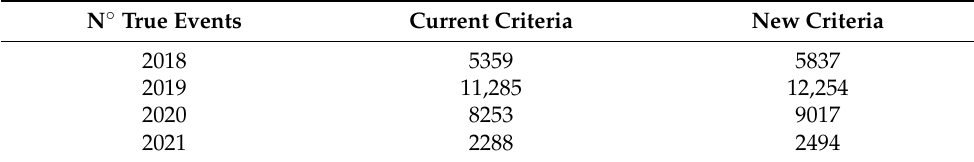
Table 6. Number of true events: criteria